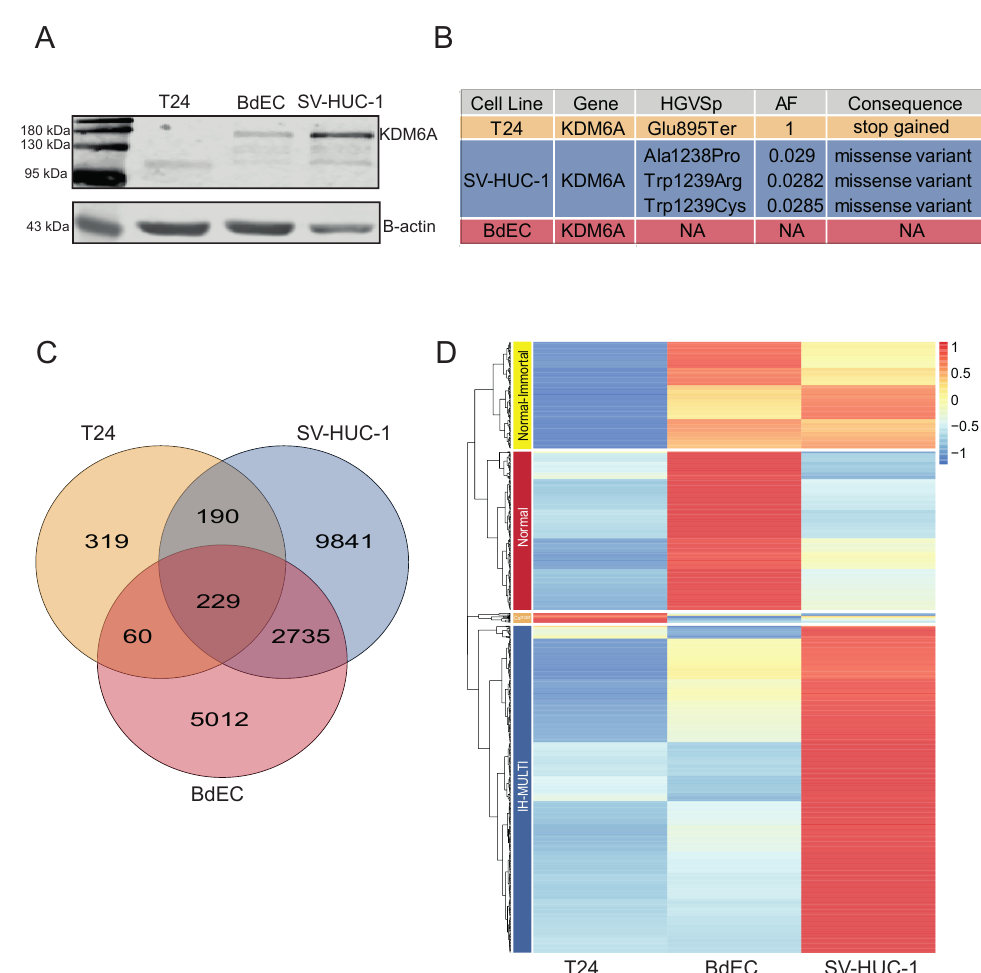
Figure 1. Occupancy and mutation profile of KDM6A in different bladder cell lines. ( A ) Western blot image displaying expression of KDM6A at protein level. ( B ) Image represents the details concerning depth, allele frequency, and alternative alleles related to mutation status of KDM6A . ( C ) Venn diagram showing the overlap among KDM6A peaks called in T24, SV-HUC-1, and BdEC cell lines. ( D ) Heatmap shows the hierarchical clustering of KDM6A peaks, resulting in 4 clusters: normal-immortal ( n = 235), normal ( n = 349), cancer ( n = 21), and IH-MULTI ( n =